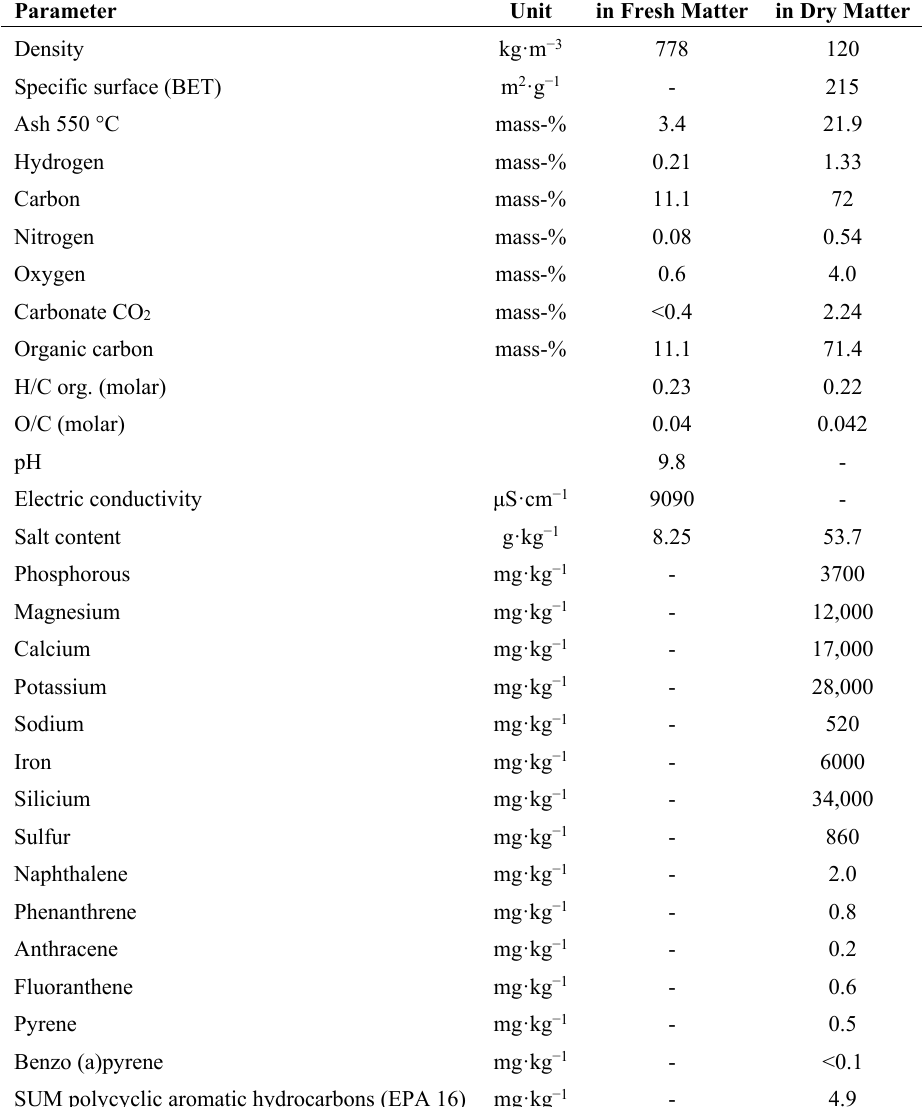
Table 2. Analytical parameters of the